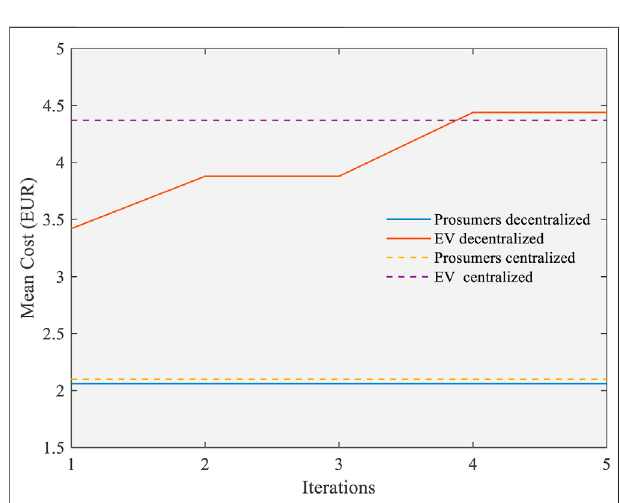
FIGURE 9 | Mean costs of Scenario